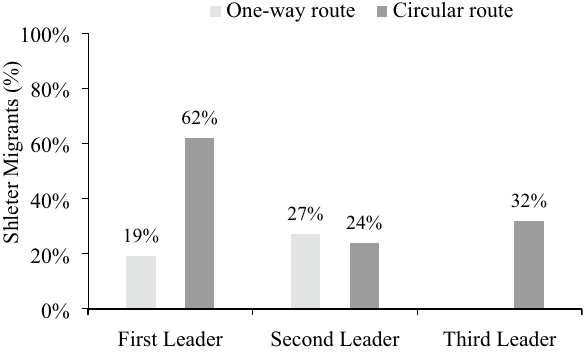
Figure 5. Sheltering by role (first, second, and third leader) and route (one-way or